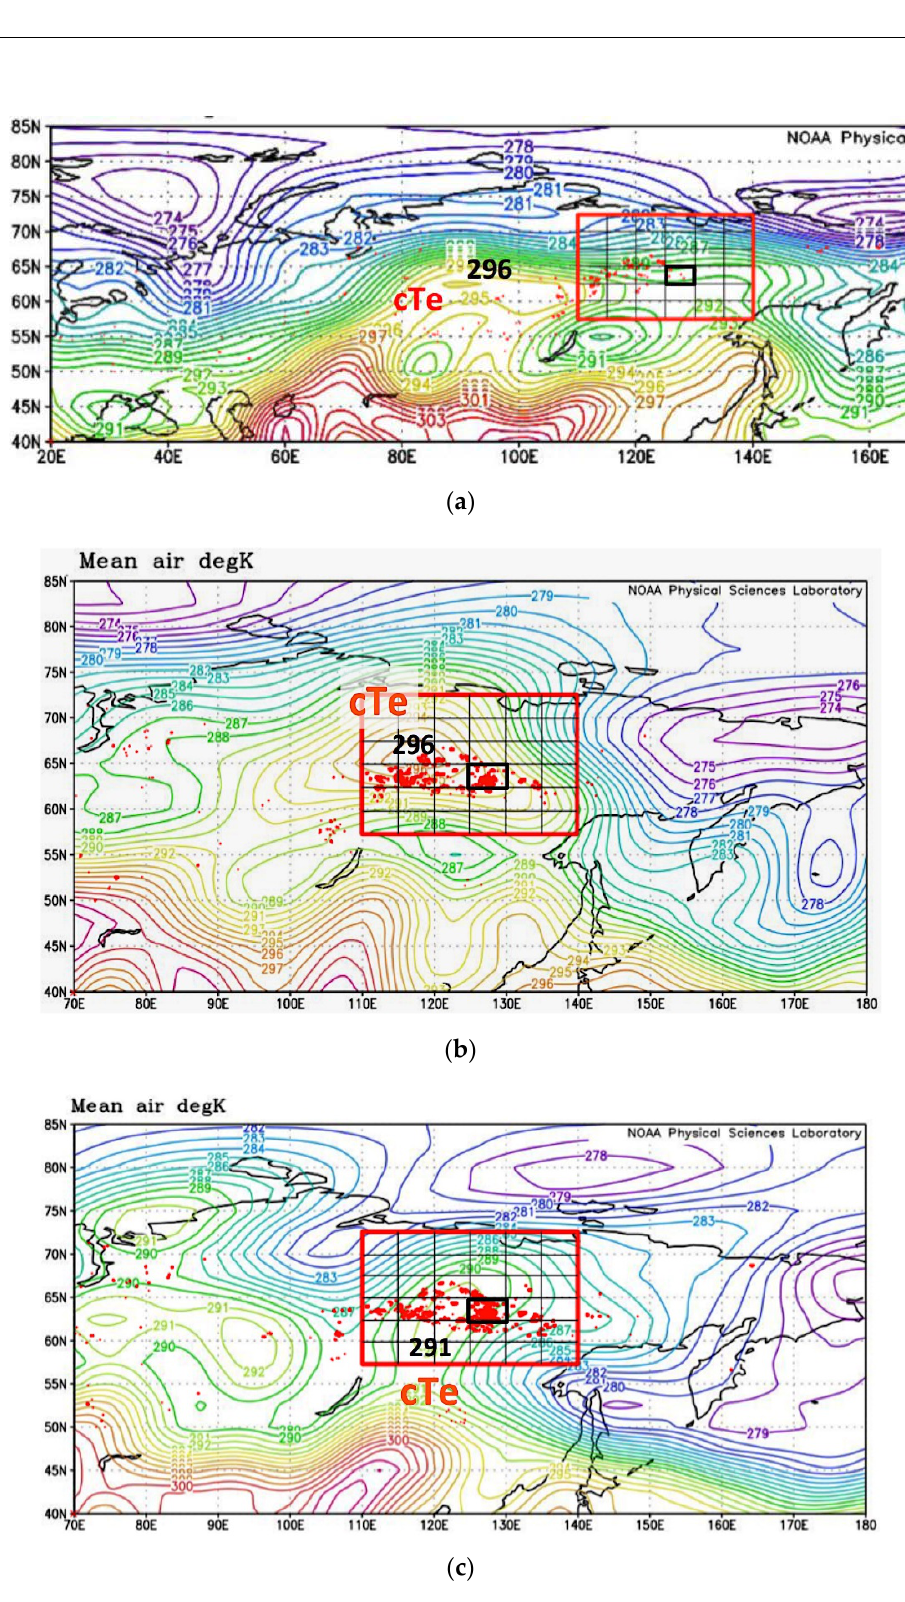
(small, black rectangle in Figure 6c) had highest number of HSs (=8175) under the exist- ence of cTe (291 K) in the central part of Sakha, as shown in Figure 6c.